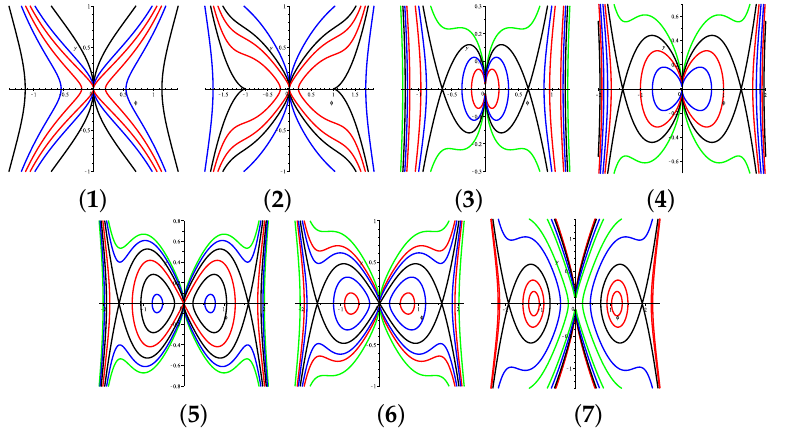
Figure 6. Phase portraits corresponding to system (5) under c > 0, ( 2 β − α )( a − 2 α ) < 0, a − 2 α <